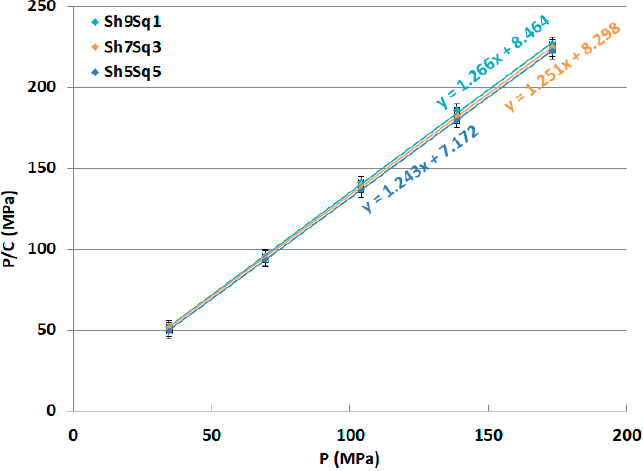
Figure 8. Kawakita plots of CH-Sh9Sq1, CH-Sh7Sq3, and CH-Sh5Sq5 CH mixtures. Table 5. Kawakita parameters of CH-Cr, CH-Sh, and CH-Sq and their mixtures.